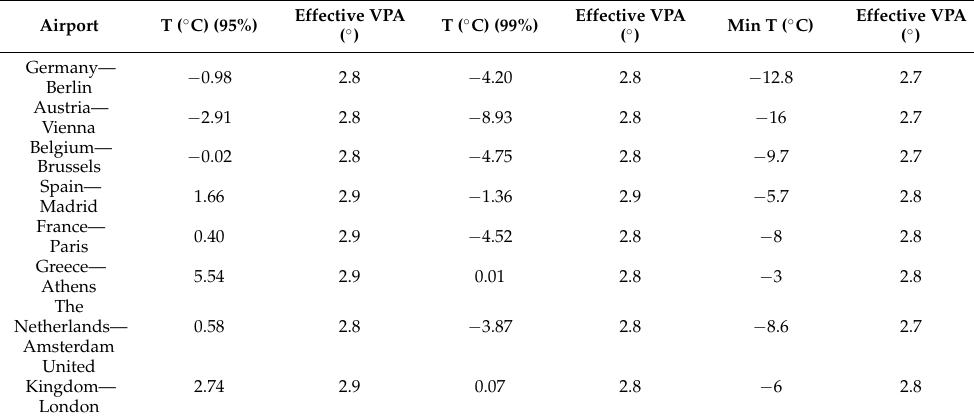
Table 6. Effective VPAs for temperature probability.